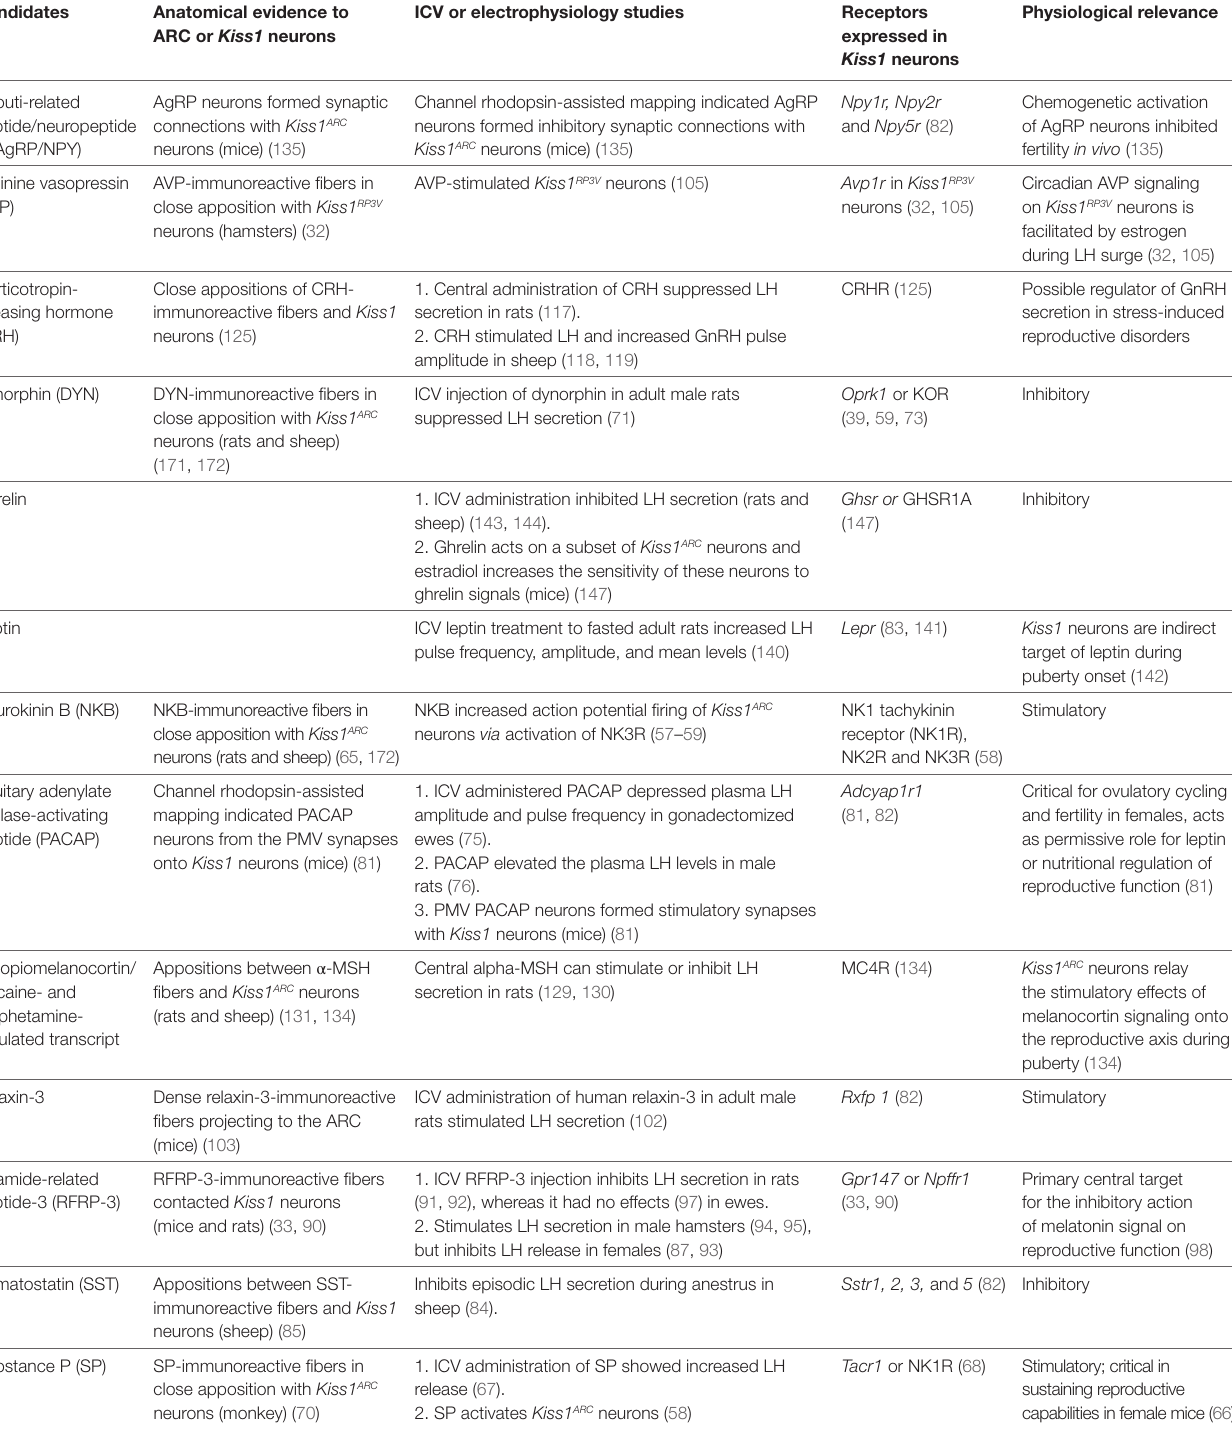
TAble 1 | Summary of neuropeptides or hormones that interact with Kiss1